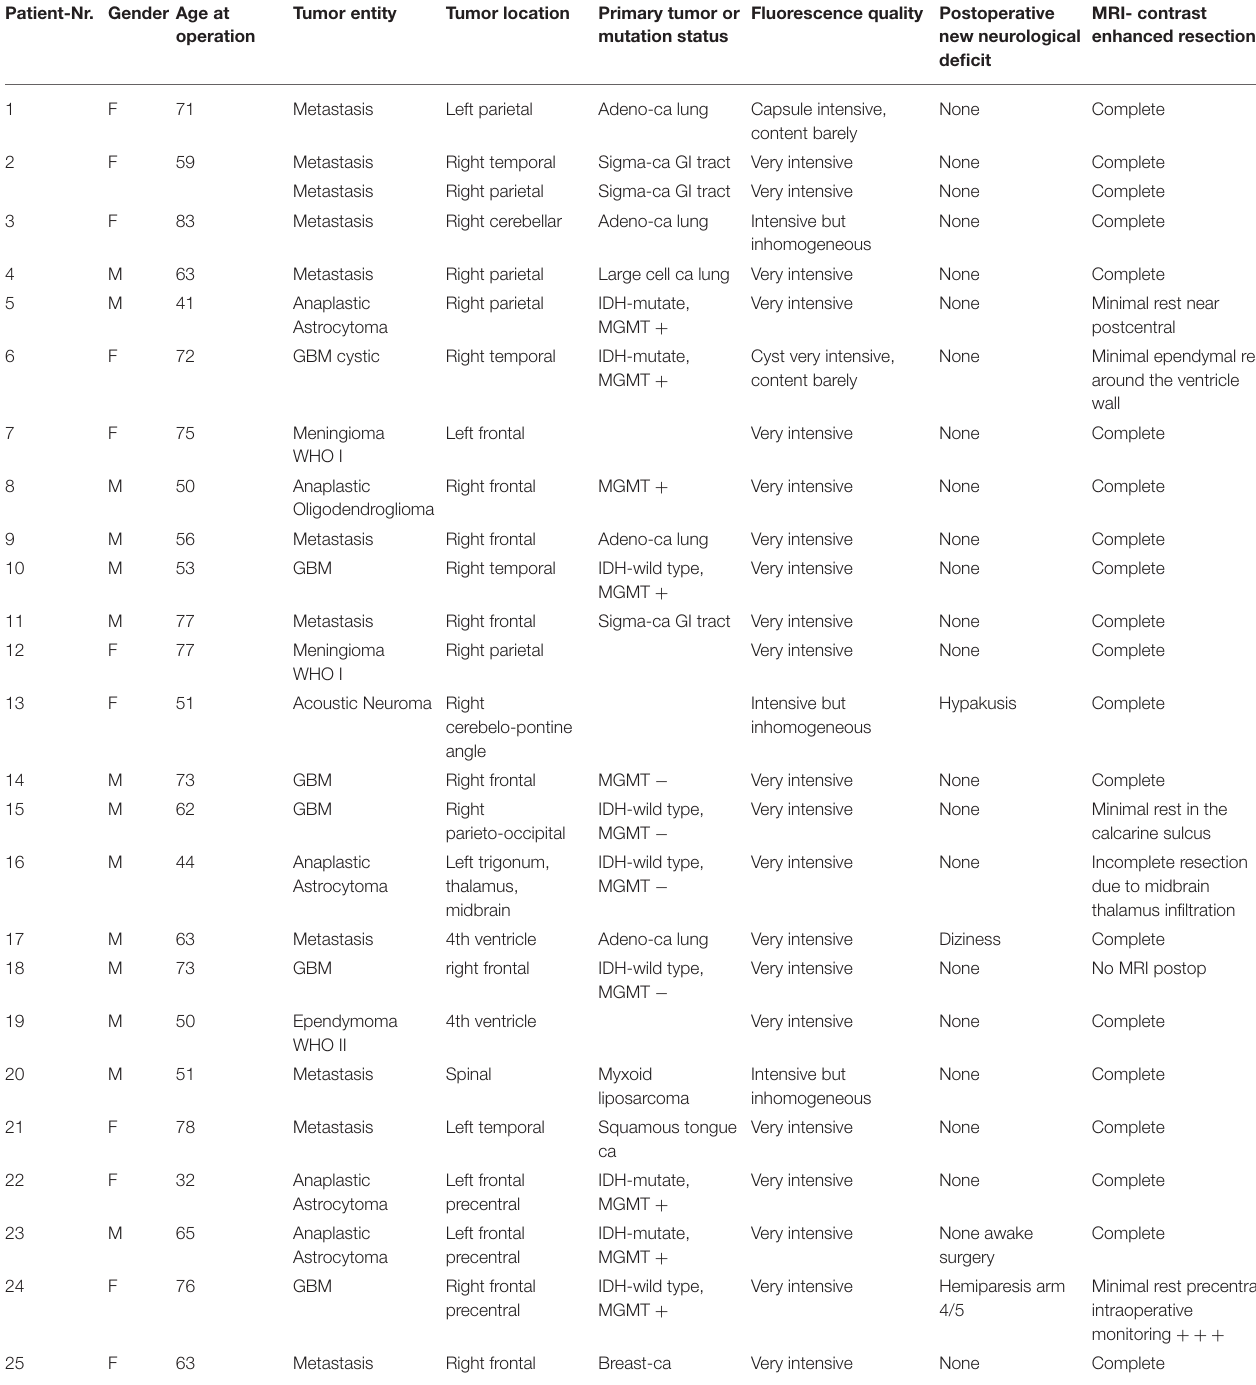
TABLE 1 | List of patients operated on with the additional use of the MFL-technique. Patient-Nr. Gender Age at